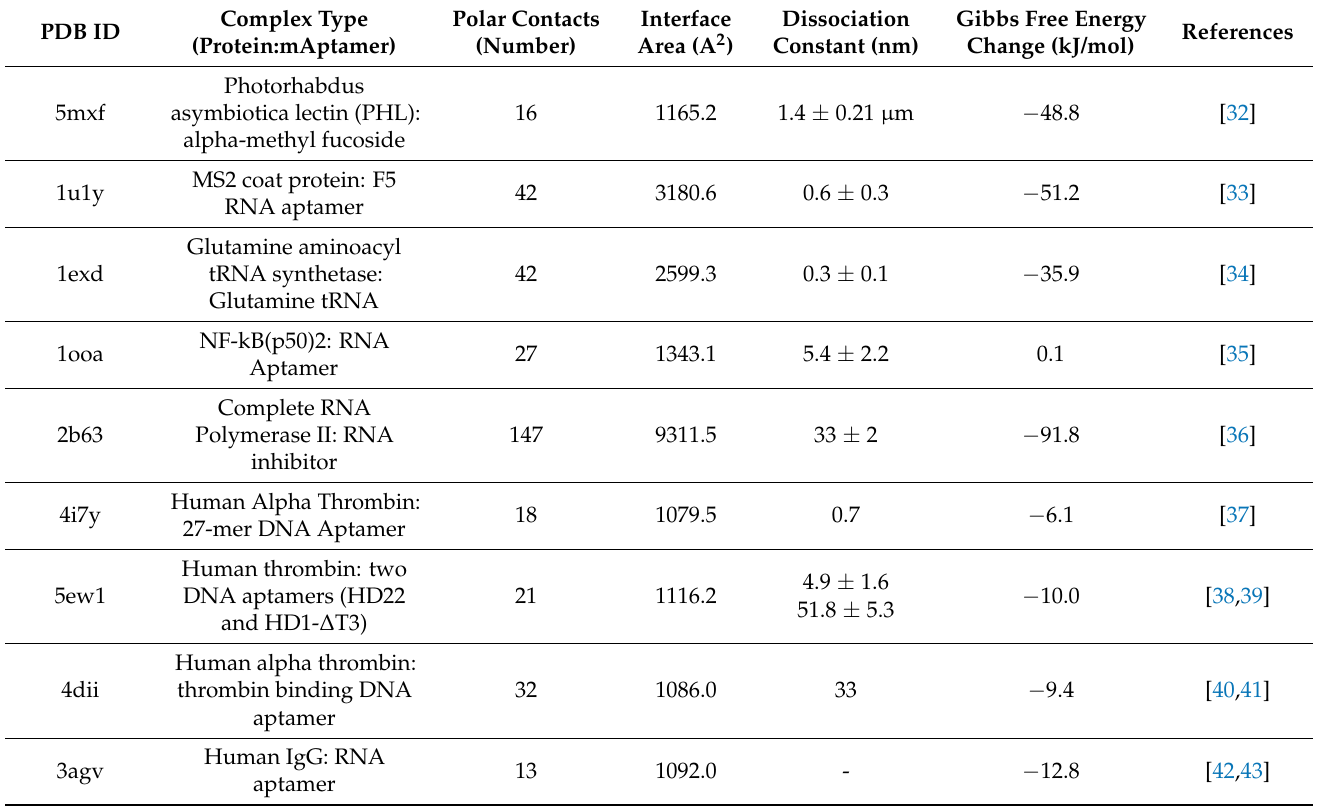
Table 2. The structural and affinity characteristics of aptamer–protein